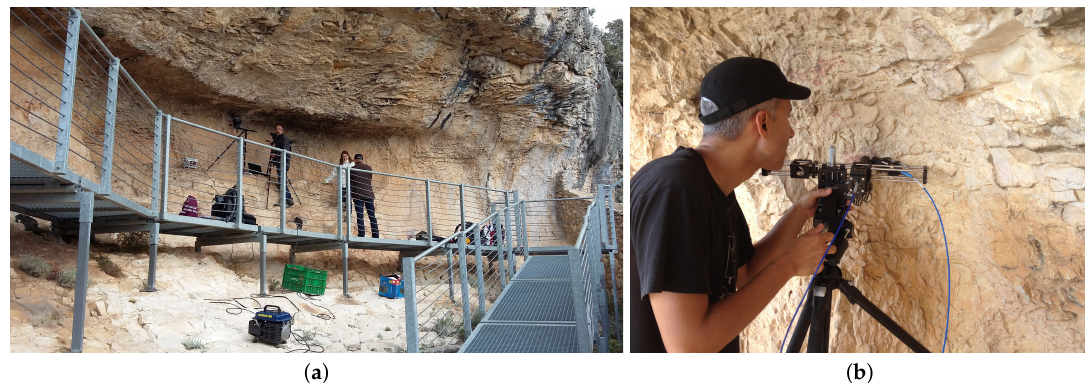
Figure 1. ( a ) View of Cova Remigia in Ares del Maestrat, Castellón, Spain. ( b ) Placement of the MFS instrument for one